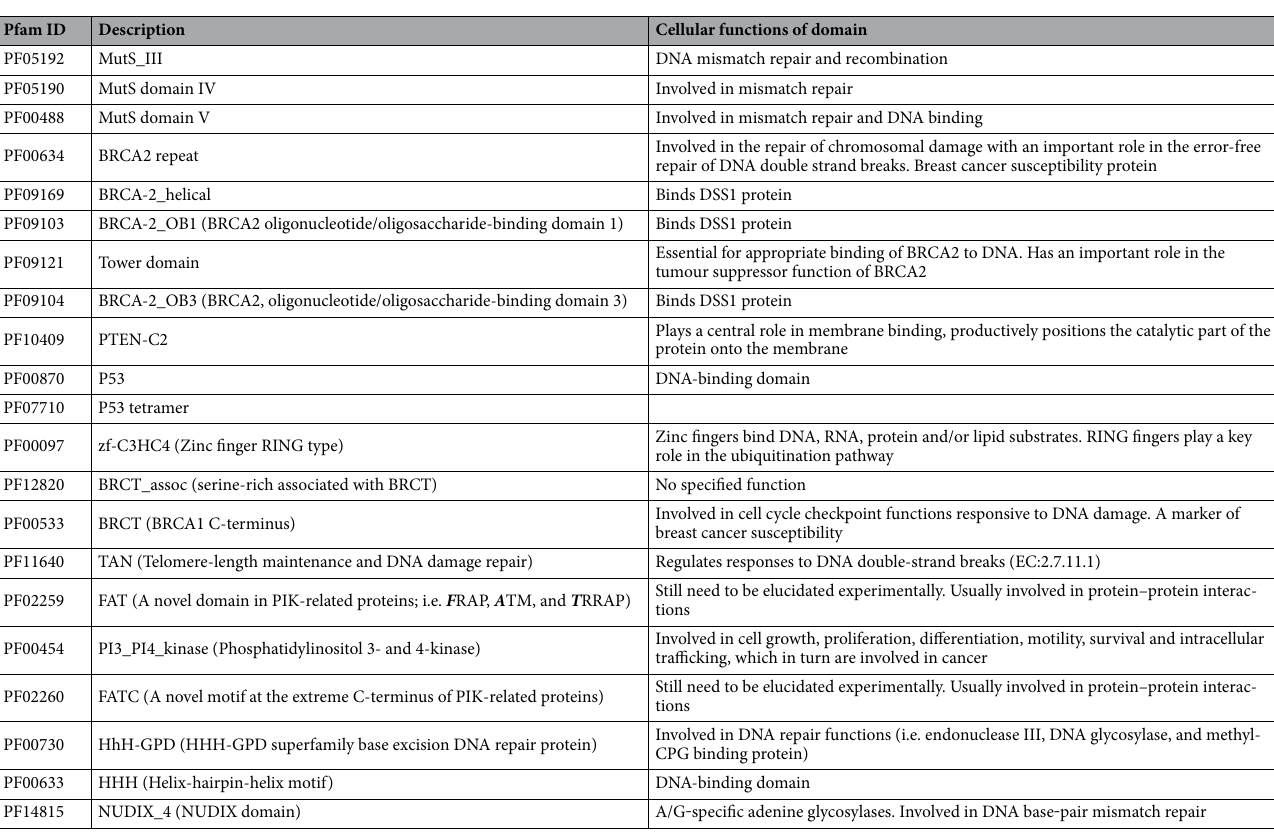
Table 1. List of Pfam domains affected by germline and somatic mutations in the DDR